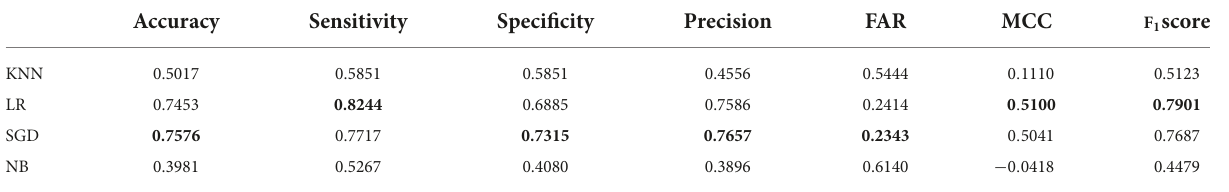
TABLE 6 PD-detection performance metrics for four different classifiers by using articulation features selected by Least Absolute Shrinkage and Selection Operator selection algorithm.